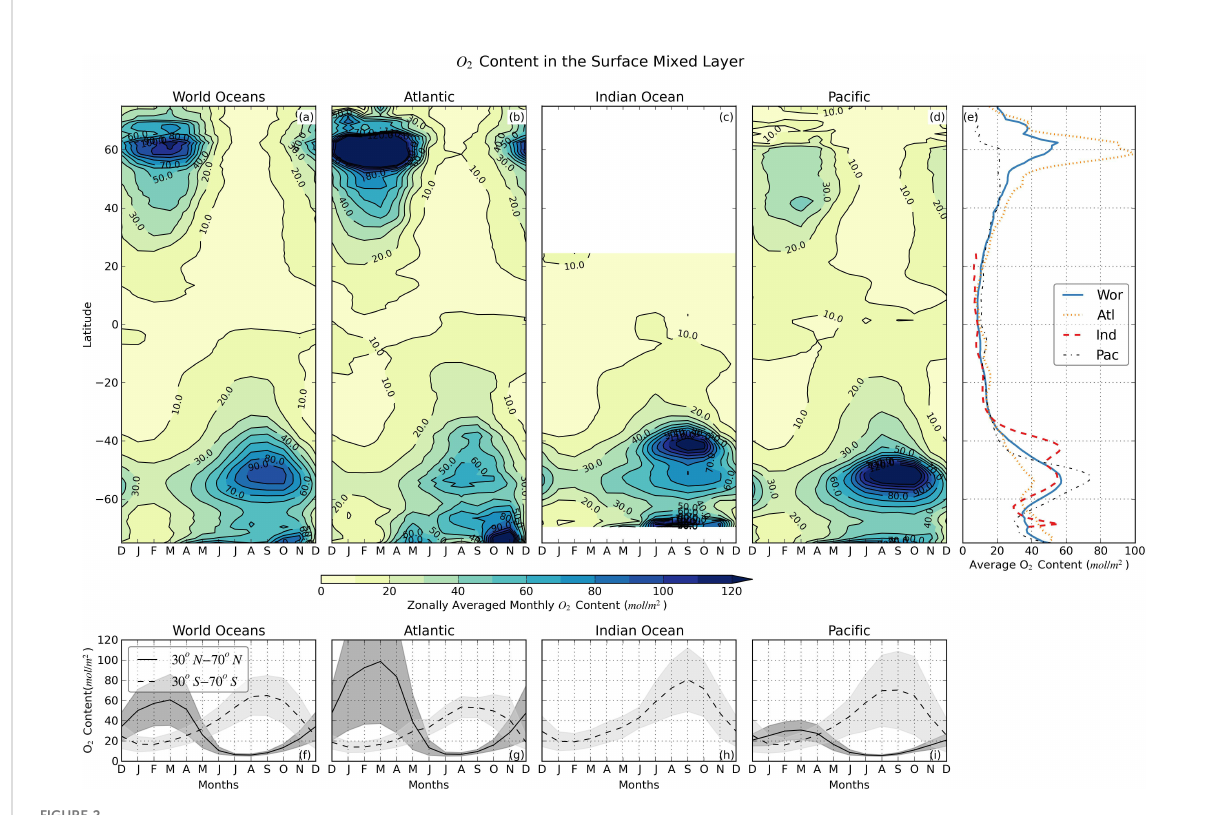
FIGURE 2 Climatology of area-averaged O 2 C in the surface mixed layer ( mol/m 2 ). Zonally averaged monthly O 2 C in the mixed layer for the (A) World, (B) Atlantic, (C) Indian, and (D) Paci fi c Ocean. Same colorbar is used for panels (A – D) as shown below them. The contour interval is 10.0 mol/ m 2 . (E) Annual zonally-averaged O 2 C for the world ocean and the three major basins. Monthly time series estimate of the O 2 C between 30° and 70° latitude for the (F) World, (G) Atlantic, (H) Indian and (I) Paci fi c Ocean, respectively. The shadow areas in (F – I) represent the data variability (±1 SD). Note O 2 C in this fi gure is area-averaged to compare the values of the world ocean with the three